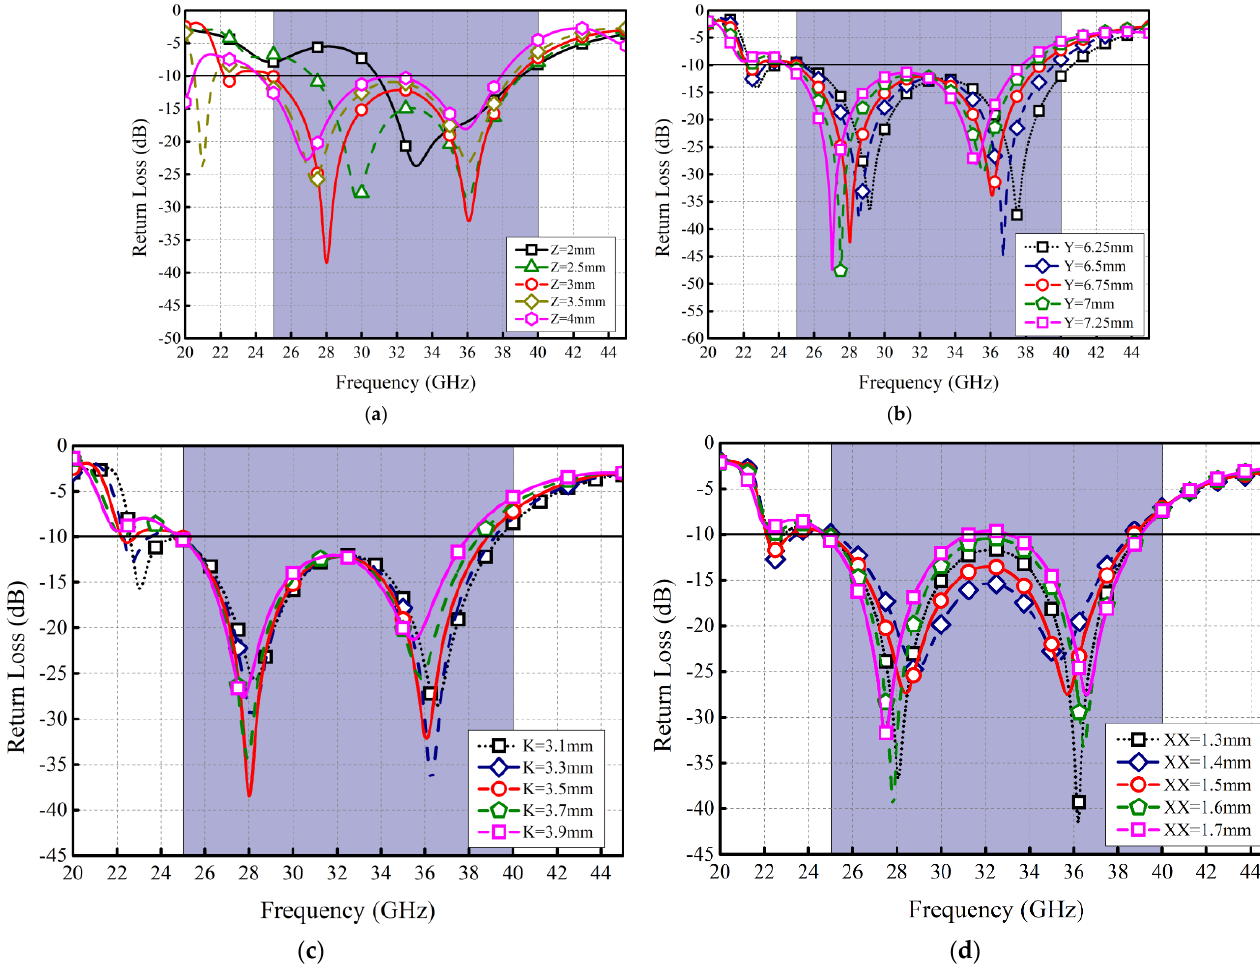
Figure 3. Parametric Studies conducted ( a ) Z ( b ) Y ( c ) K ( d ) XX.